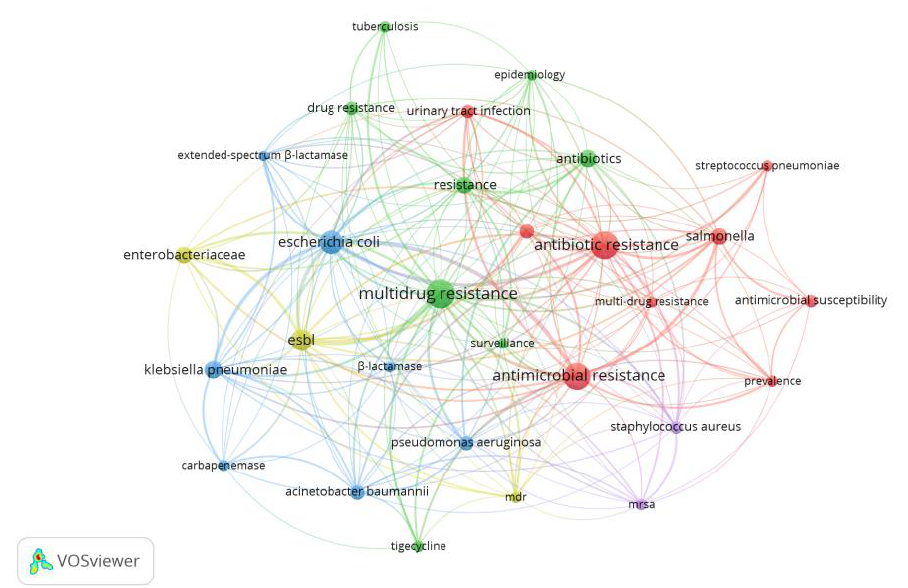
Figure 5. Research topic network visualization of publications related to CA and multidrug resistance in the period between 2008 and 2017. Note: The minimum number of occurrences of a keyword is